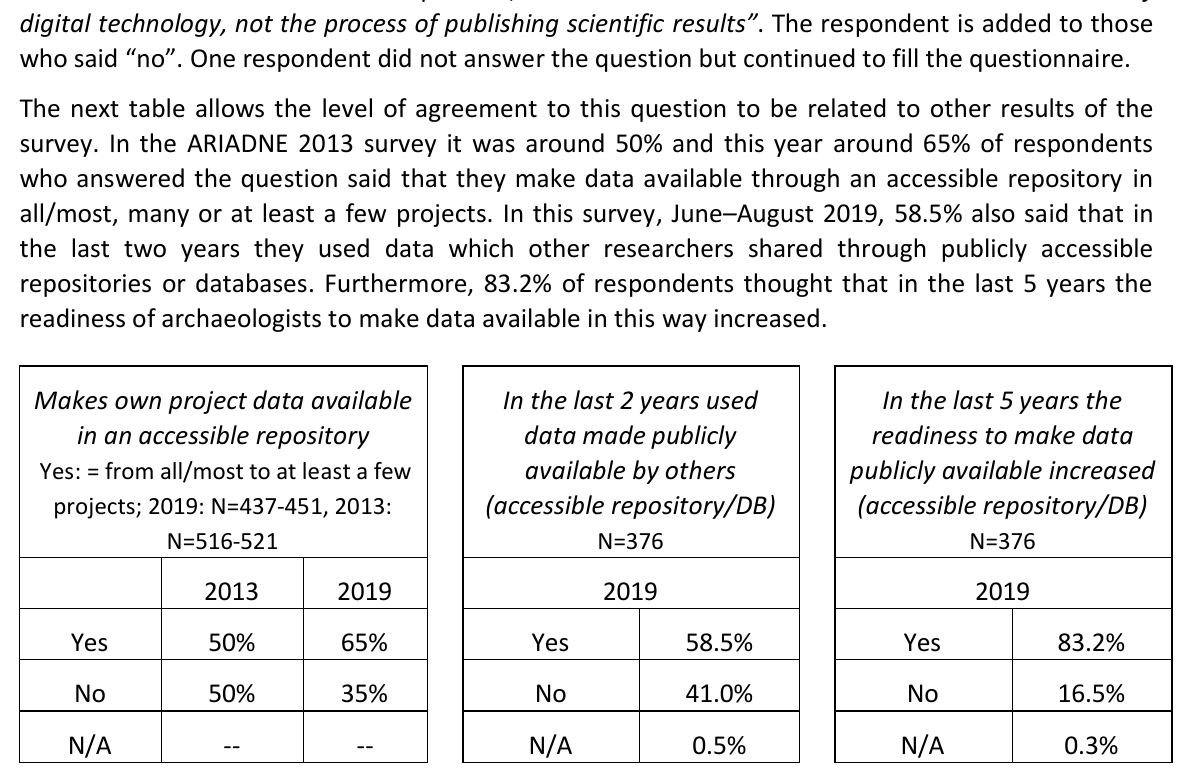
Table 14 : Comparison of data sharing (2013/2019, data (re)use, and increase of readiness to